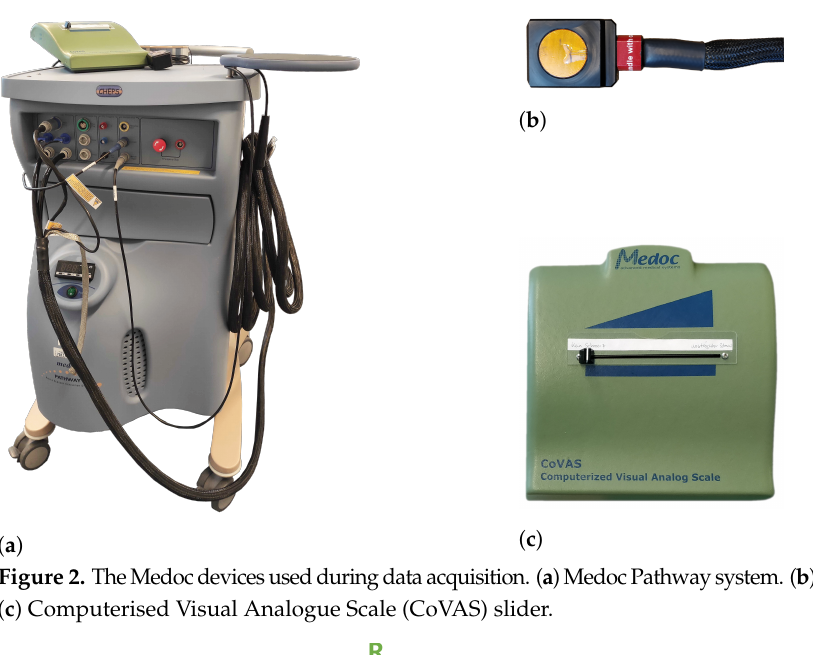
Figure 2. TheMedocdevicesusedduringdataacquisition. ( a )MedocPathwaysystem. ( b )Cheps thermode. ( c ) Computerised Visual Analogue Scale (CoVAS) slider.